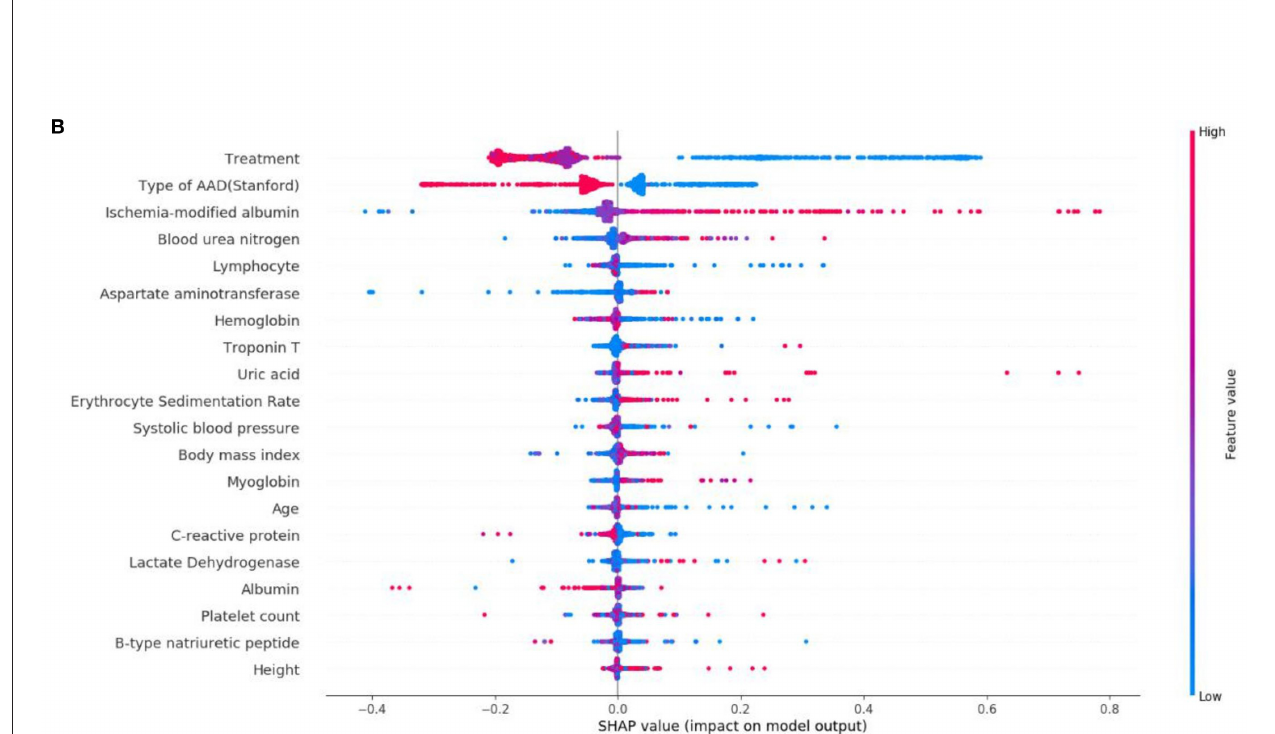
Frontiers in Cardiovascular Medicine |